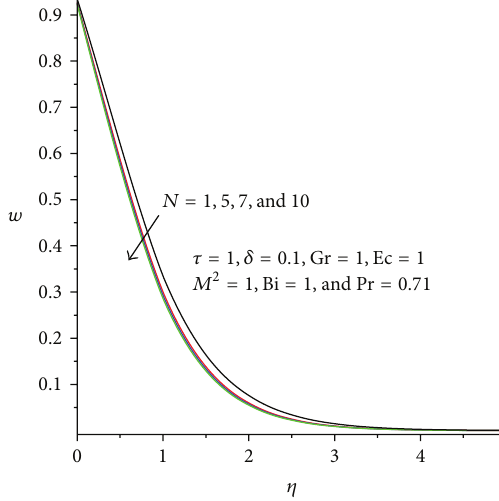
Figure 7: Velocity profiles with increasing 𝑀 .